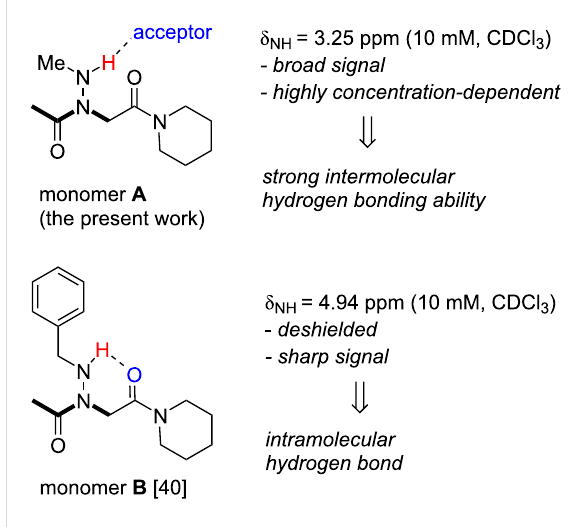
Figure 5: Comparison of monomers A and B with respect to their ability to form intramolecular and intermolecular hydrogen bonds.